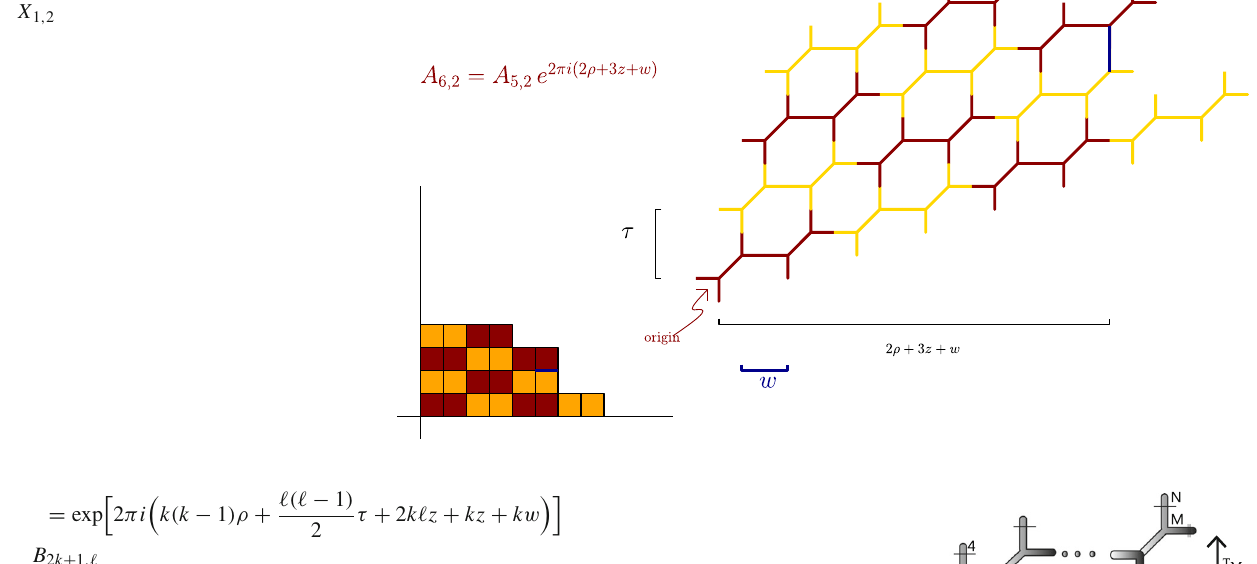
Fig. 4 Tessellation of Newton polygons and web diagram of X